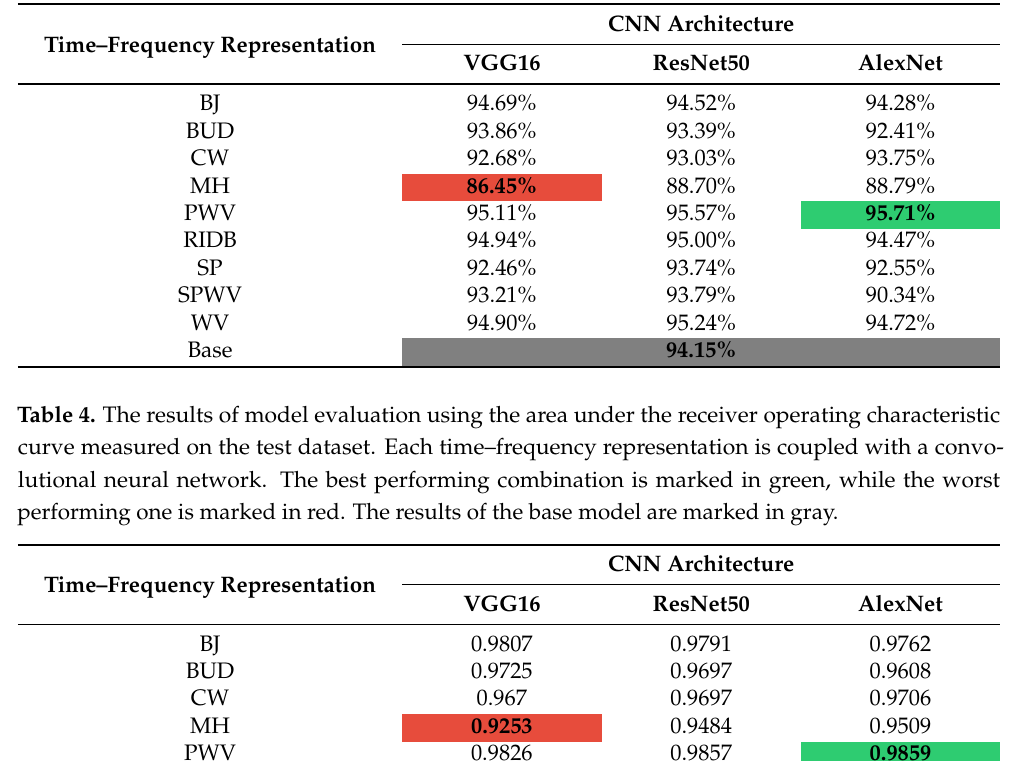
Table 3. The results of model evaluation using classification accuracy measured on the test dataset. Each time–frequency representation is coupled with a convolutional neural network. The best performing combination is marked in green, while the worst performing one is marked in red. The results of the base model are marked in gray.